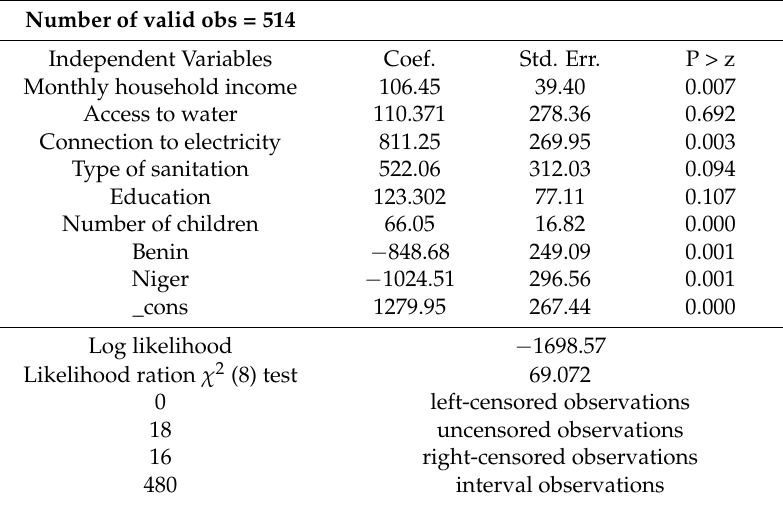
Table 12. WTP for domestic water drinking provision—interval regression